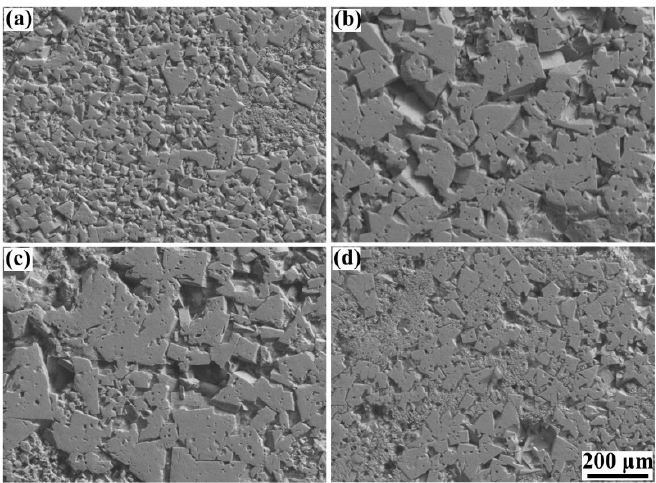
Figure 12. The microstructure of cemented carbide blocks formed under different laser energy densities and scanning strategies: ( a ) Scan I, 116.37 J/mm 3 ; ( b ) Scan I, 161.41 J/mm 3 ; ( c ) Scan I, 248.84 J/mm 3 ; ( d ) Scan II, 116.37 J/mm 3